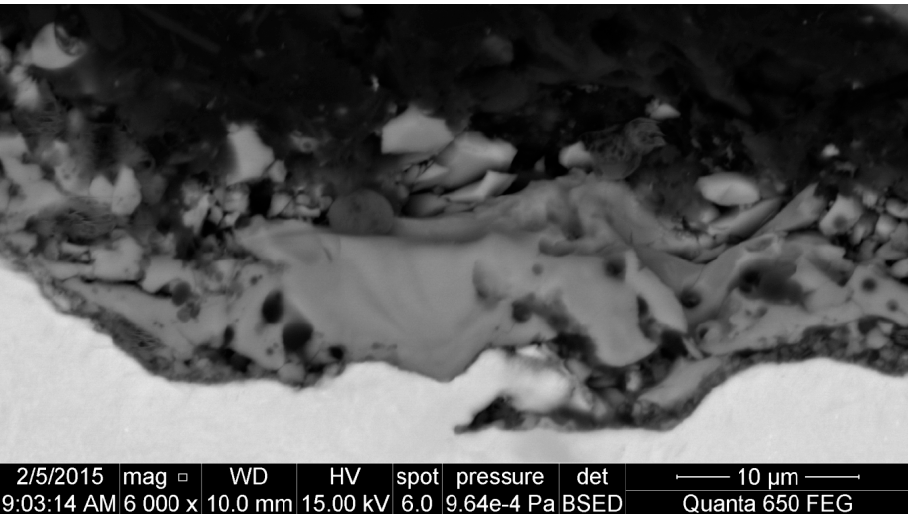
Figure 5. Cross-section of the PEO surface layer formed on titanium after PEO at 450 V.